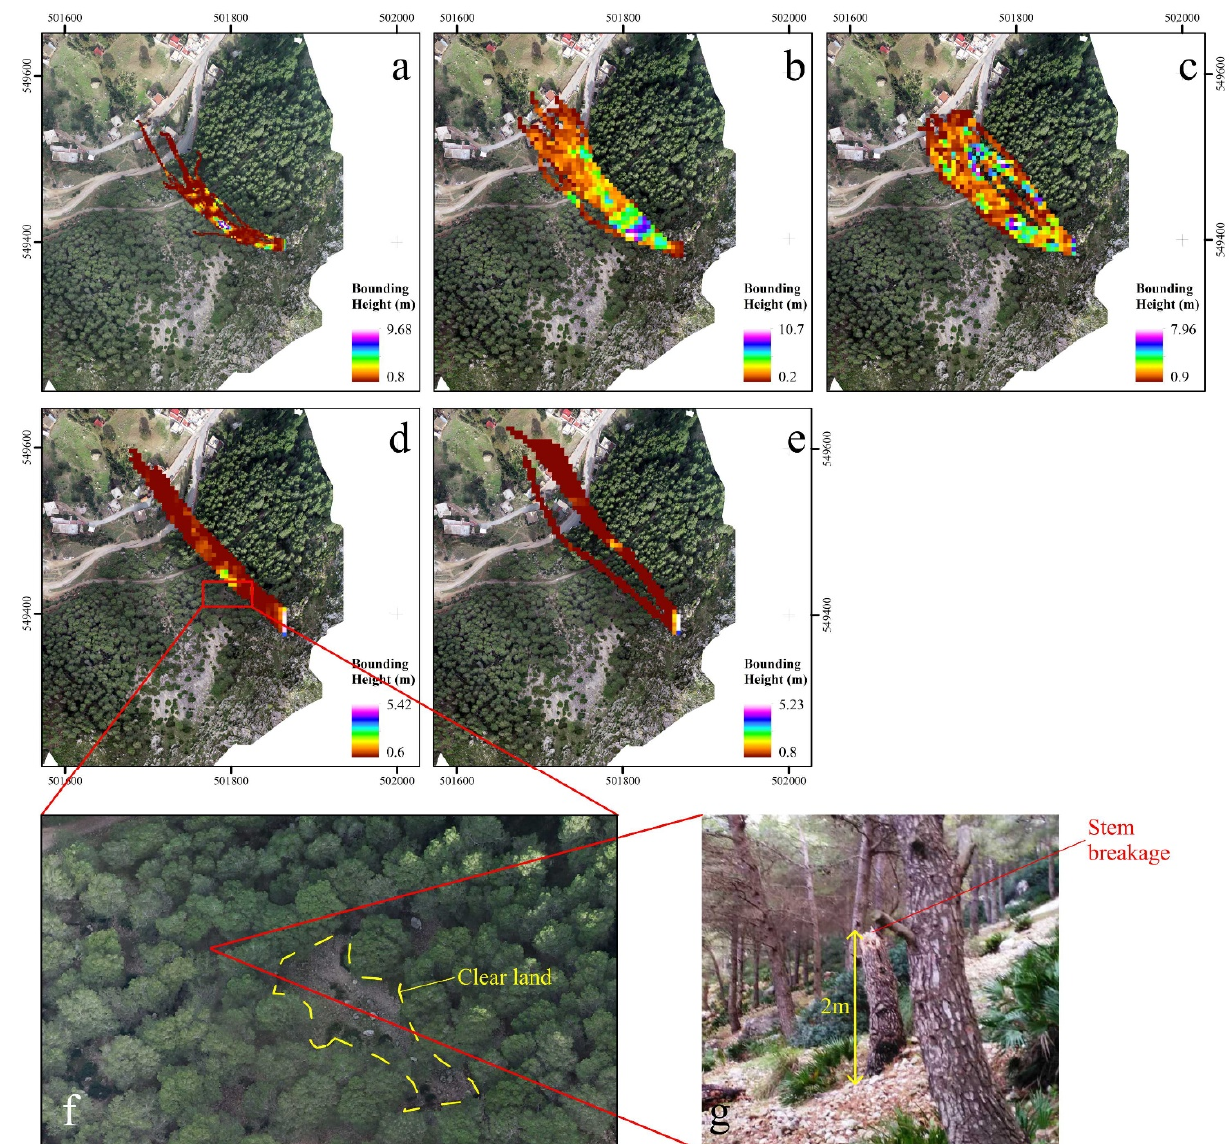
Figure 13. Bouncing height simulations produced using the 1 m DEM ( a ), the 5 m DEM ( b ) and the 30 m DEM ( c ). ( d ) UAV ‐ derived orthoimage showing clear land caused by repetitive rockfall events. ( e ) stem breakage caused by an old rockfall occurrence. the 30 m DEM ( c ). ( d ) UAV-derived orthoimage showing clear land ( f ) caused by repetitive rockfall events. ( e ) stem breakage ( g ) caused by an old rockfall